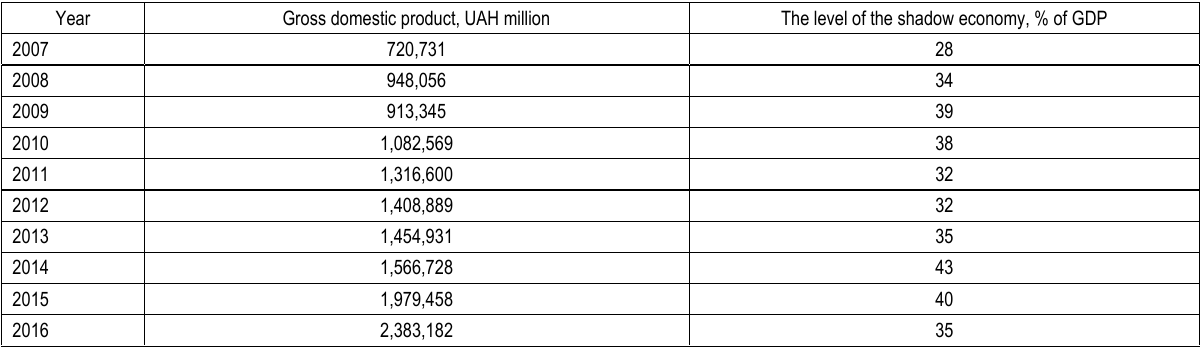
Table 1. The level of the shadow economy in Ukraine in 2007 – 2016, % of